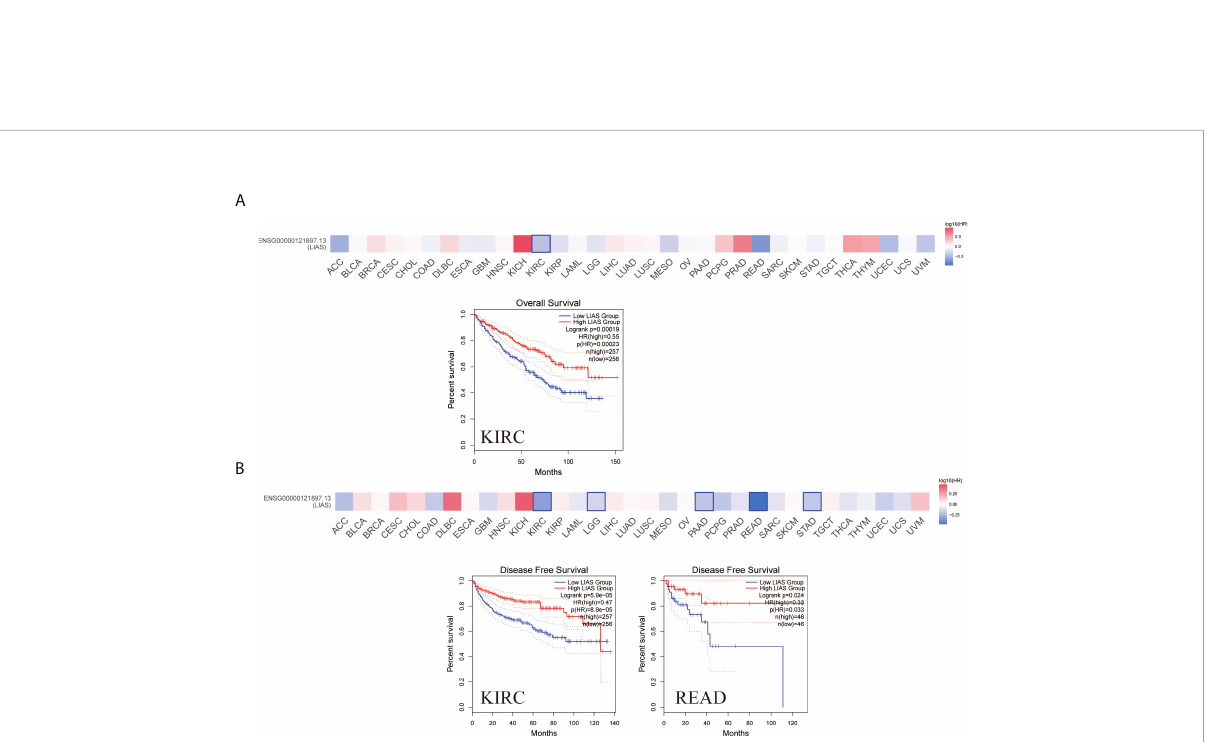
FIGURE 3 The prognostic values of LIAS across cancers. (A, B) GEPIA2.0 portrayed the effects of LIAS expression on the overall survival (A) and disease- free survival (B) in TCGA